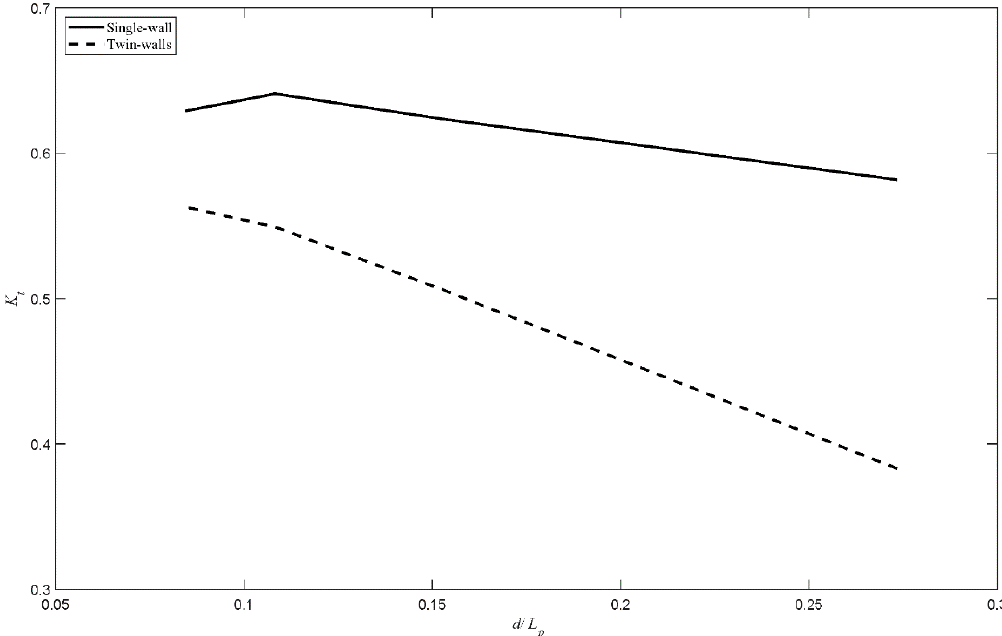
= 20%, θ = 90, and H = t with for P is / d